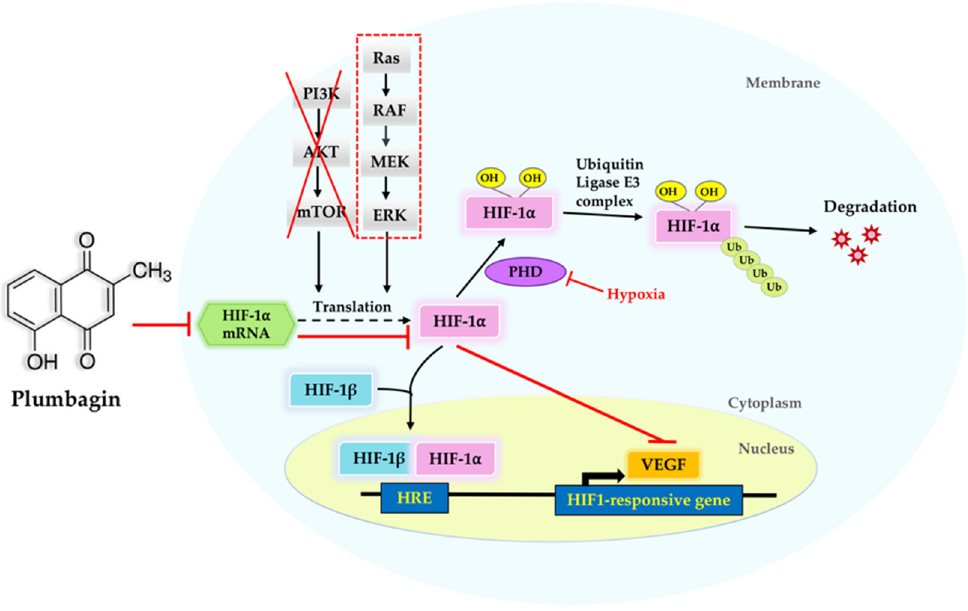
Figure 7. A proposed mechanism of action of plumbagin on MCF-7 cells.